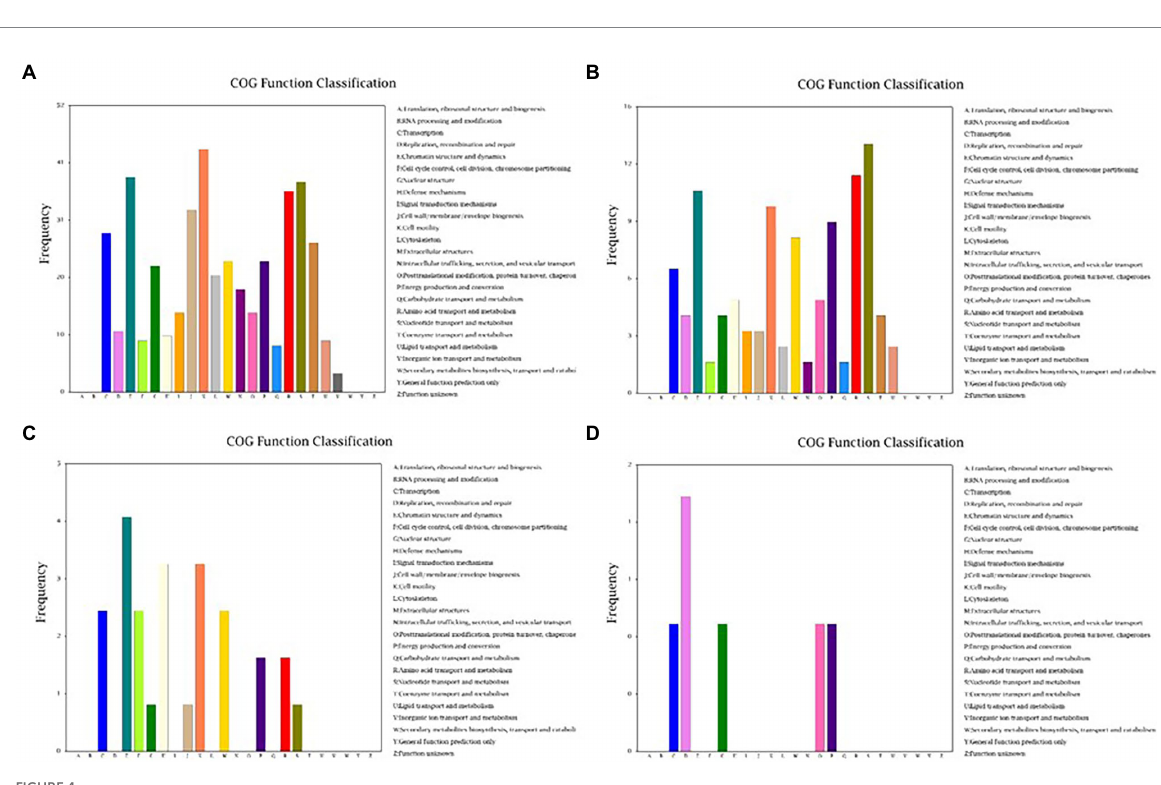
FIGURE 4 Cluster of Orthologous Groups of Proteins (COG) function classification of the DEGs of B. subtilis 1JN2 after Cd2 + treatment. (A–D) Means the comparison of DEGs according to COG function classification between S1 and S2, S2 and S3, S3 and S4, S4 and S5 separately.